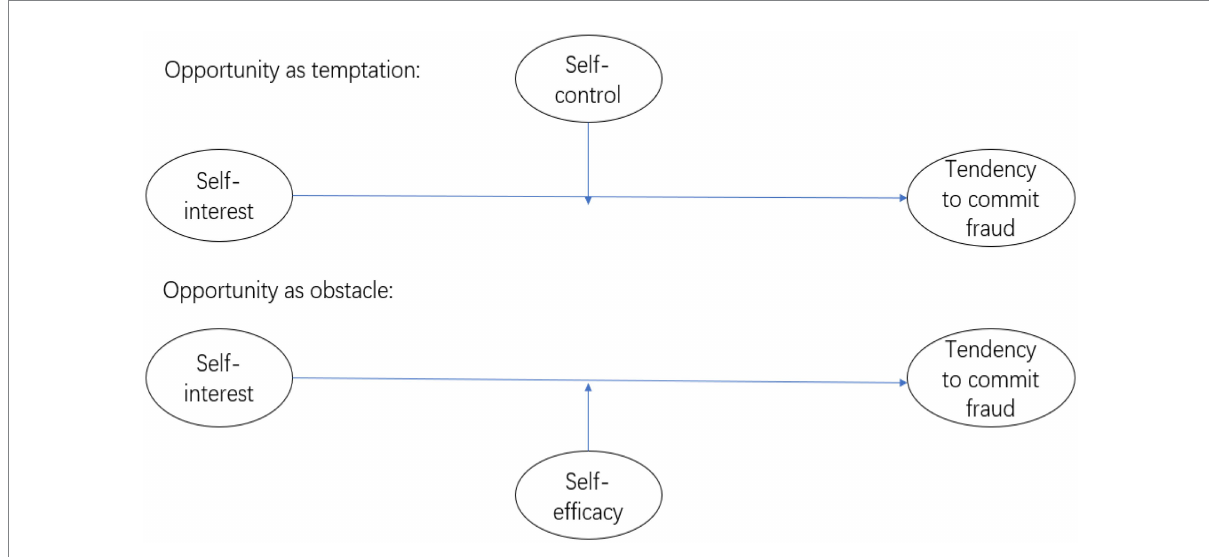
FIGURE 1 The research